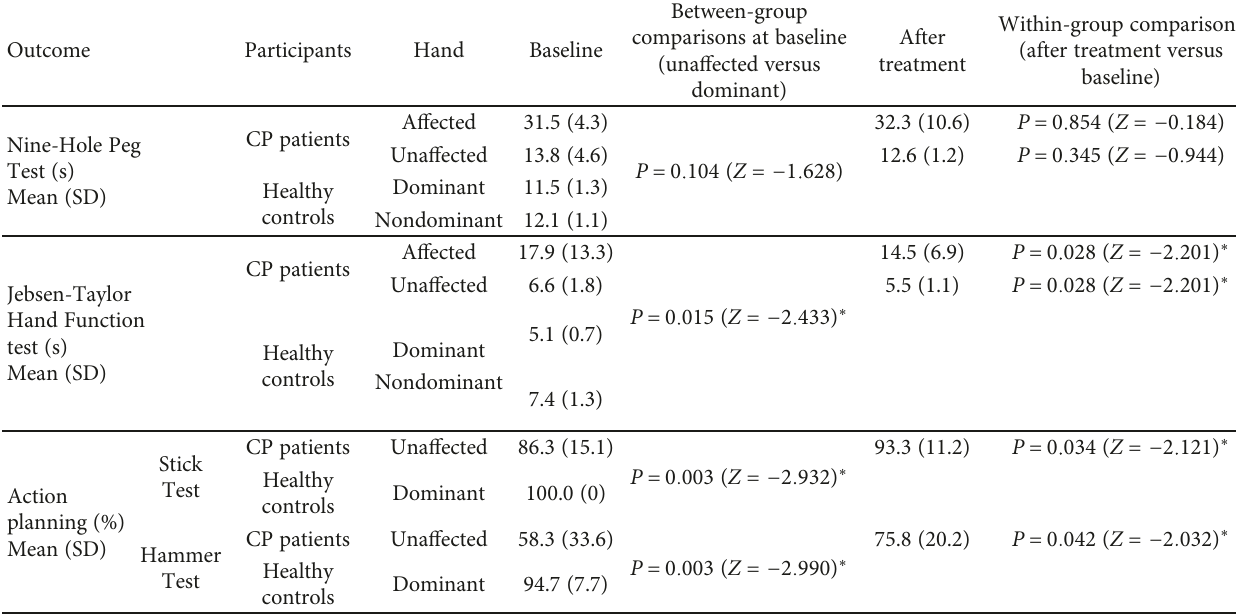
Table 2: Performance on outcome